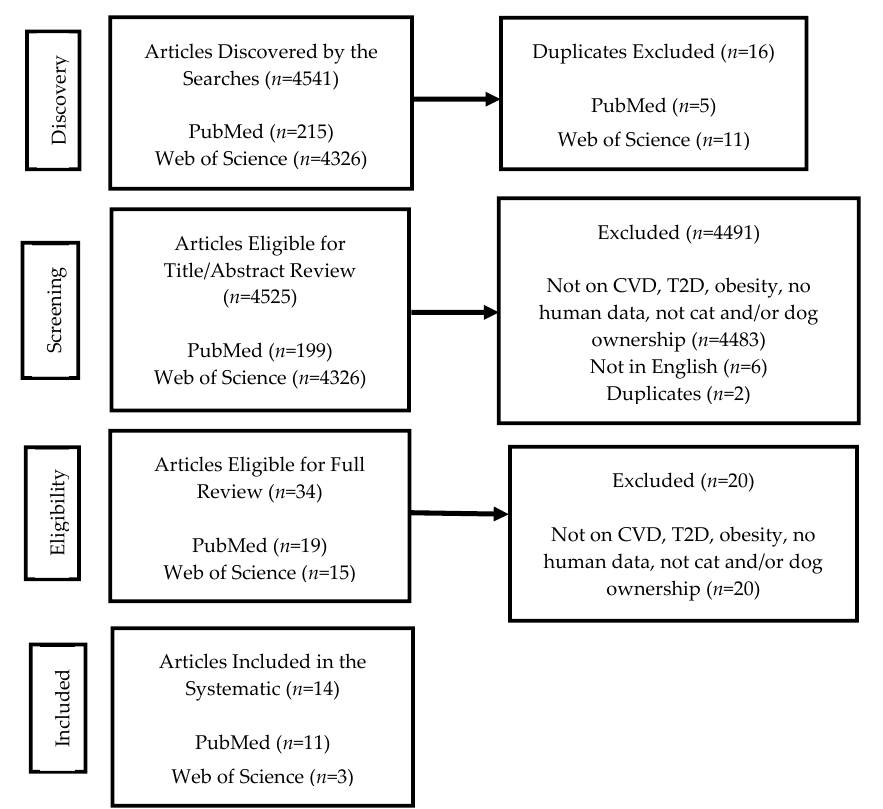
Figure 1. Flow diagram of studies identified and included in the systematic review.